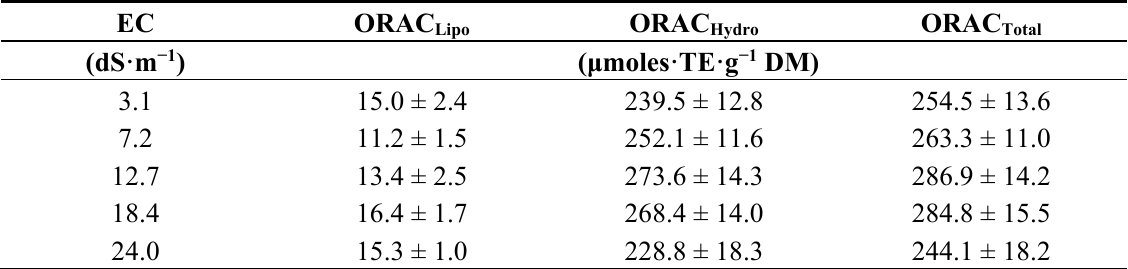
Table 4. Oxygen radical absorbance capacity of the lipophilic (ORAC Lipo ) and hydrophilic (ORAC Hydro ) fractions, and total antioxidant capacity (ORAC Hydro + ORAC Lipo ), in micromoles of trolox equivalents per gram of dry matter (µmoles·TE·g − 1 DM) of alfalfa irrigated with water of different electrical conductivities (EC). Plants were sampled on 17 April 2012 (299 DAS). Data are means ± SE combined for the four cultivars with two replicated analyses per sample ( n = 8).